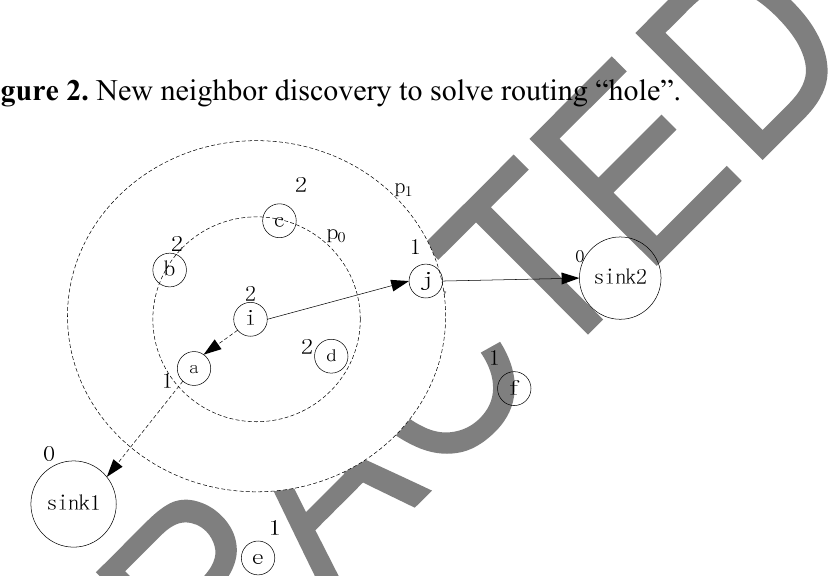
Figure 2. New neighbor discovery to solve routing